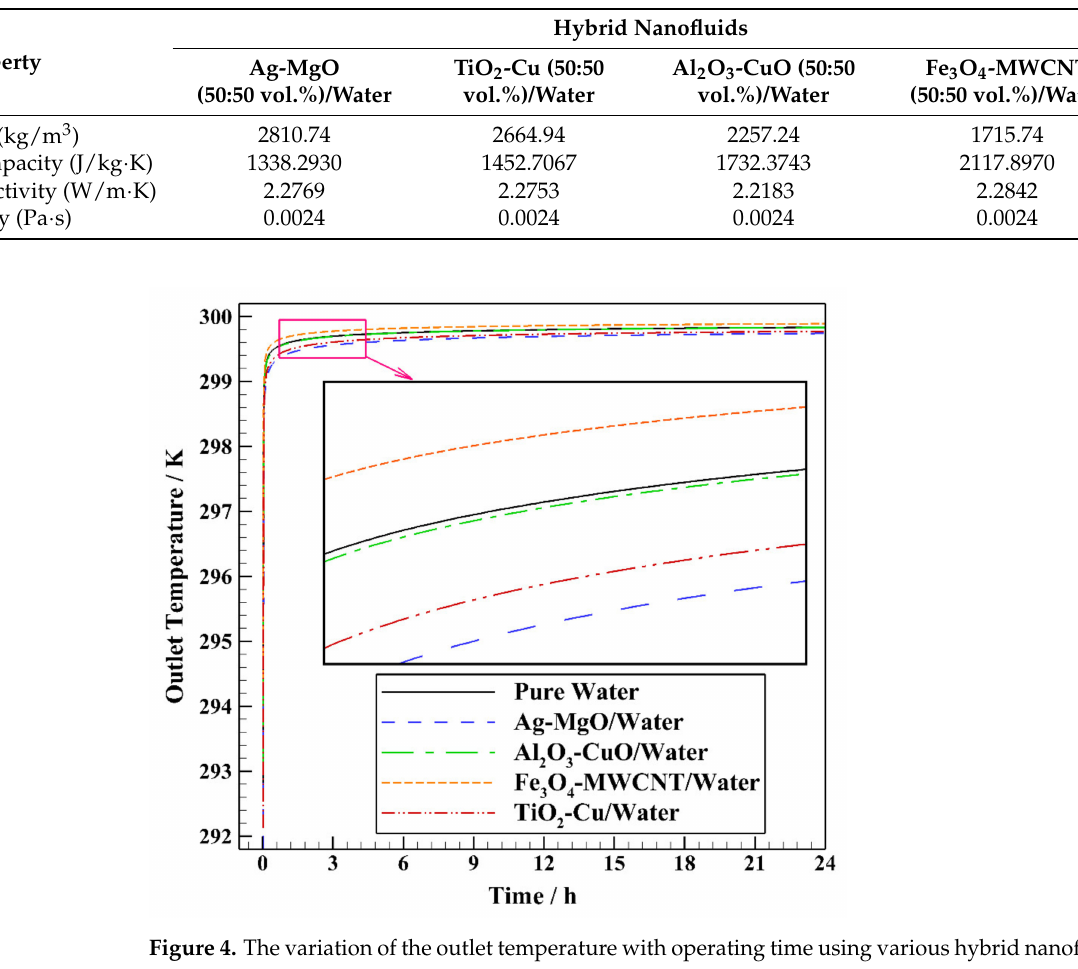
Table 4. Thermo-physical properties of various hybrid nanofluids at φ = 0.15.